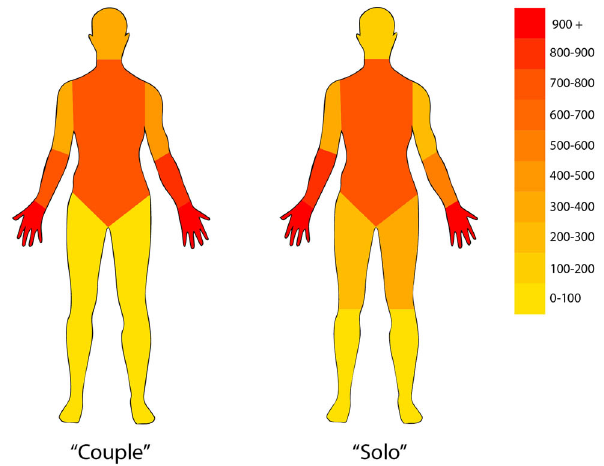
Figure 14: Body maps showing the distribution of virtual touch in VR in both